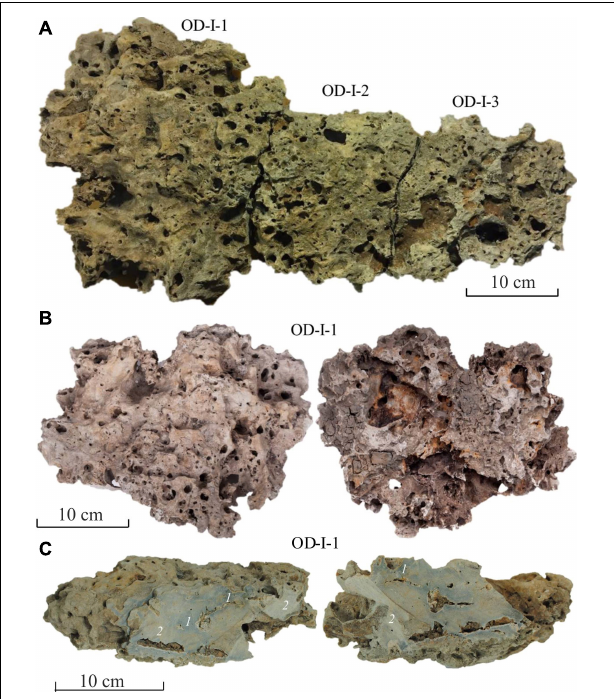
FIGURE 4 | Morphology of the carbonate crust from the Laptev Sea, depth of 63 m: (A) large carbonate crust sampled from the Oden methane seep area and its division into samples OD-I-1, OD-I-2 and OD-I-3; (B) top view (left) and bottom view (right) of the sample OD-I-1 with pores and cavities filled with bottom sediment; (C) lengthwise section (left) and cross-section (right) of the carbonate crust sample OD-I-1: 1 , examples of the dark zones and 2 , examples of the light